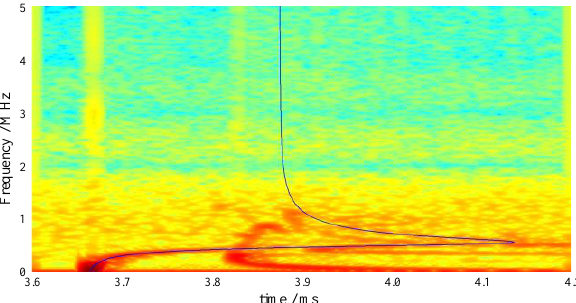
Figure 11. The first order mode included in the time-frequency joint spectrum of bar 01.